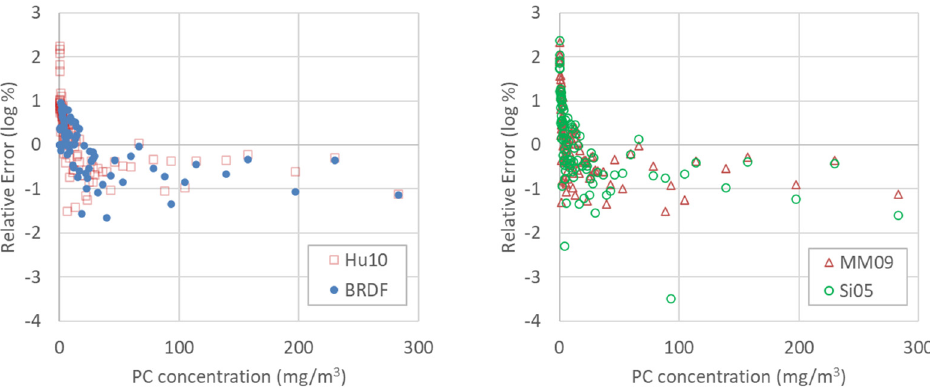
Figure 7. Comparison of relative error (log %) for each algorithm used in this study. Blue circles, red squares, red triangles, and green circles represent errors from the BRPD, Hu10, MM09, and Si05 algorithms, respectively.